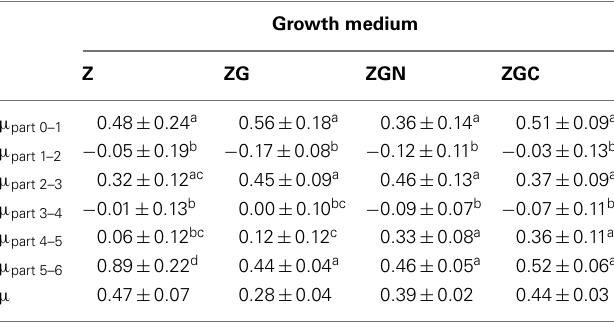
Table 5 | µ part and µ (day − 1 ; mean ± SD, n = 6) of Chlorella mirabilis during the out-door experiment (March 19–25, 2005) in control and nutrient manipulation treatments (seeTable 1 for growth media abbreviation